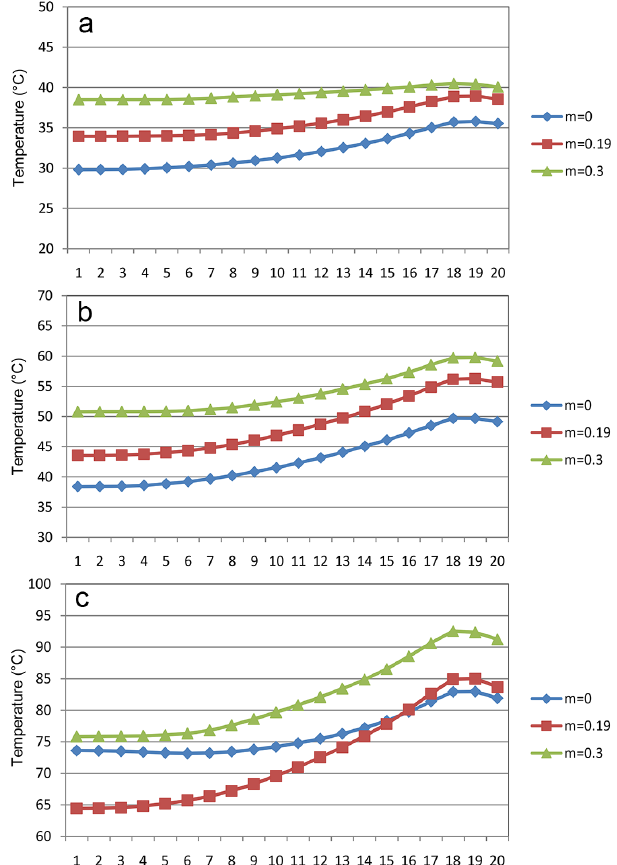
Fig.6: Temperature distribution in the centre line of the work-piece as a function of friction (a) V=0.5mm/s, (b) V=1mm/s, (c) V=2mm/s at the end of the process